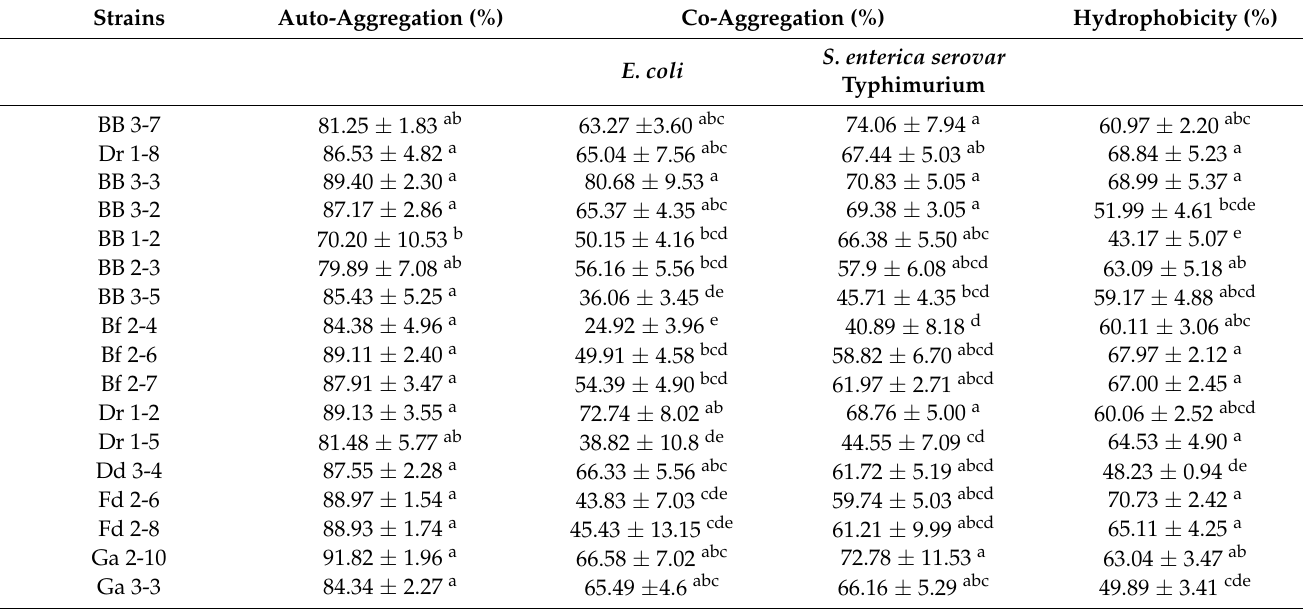
Table 3. Auto-aggregation (%) and co-aggregation with pathogens (%) and hydrophobicity (%) results for the yeast